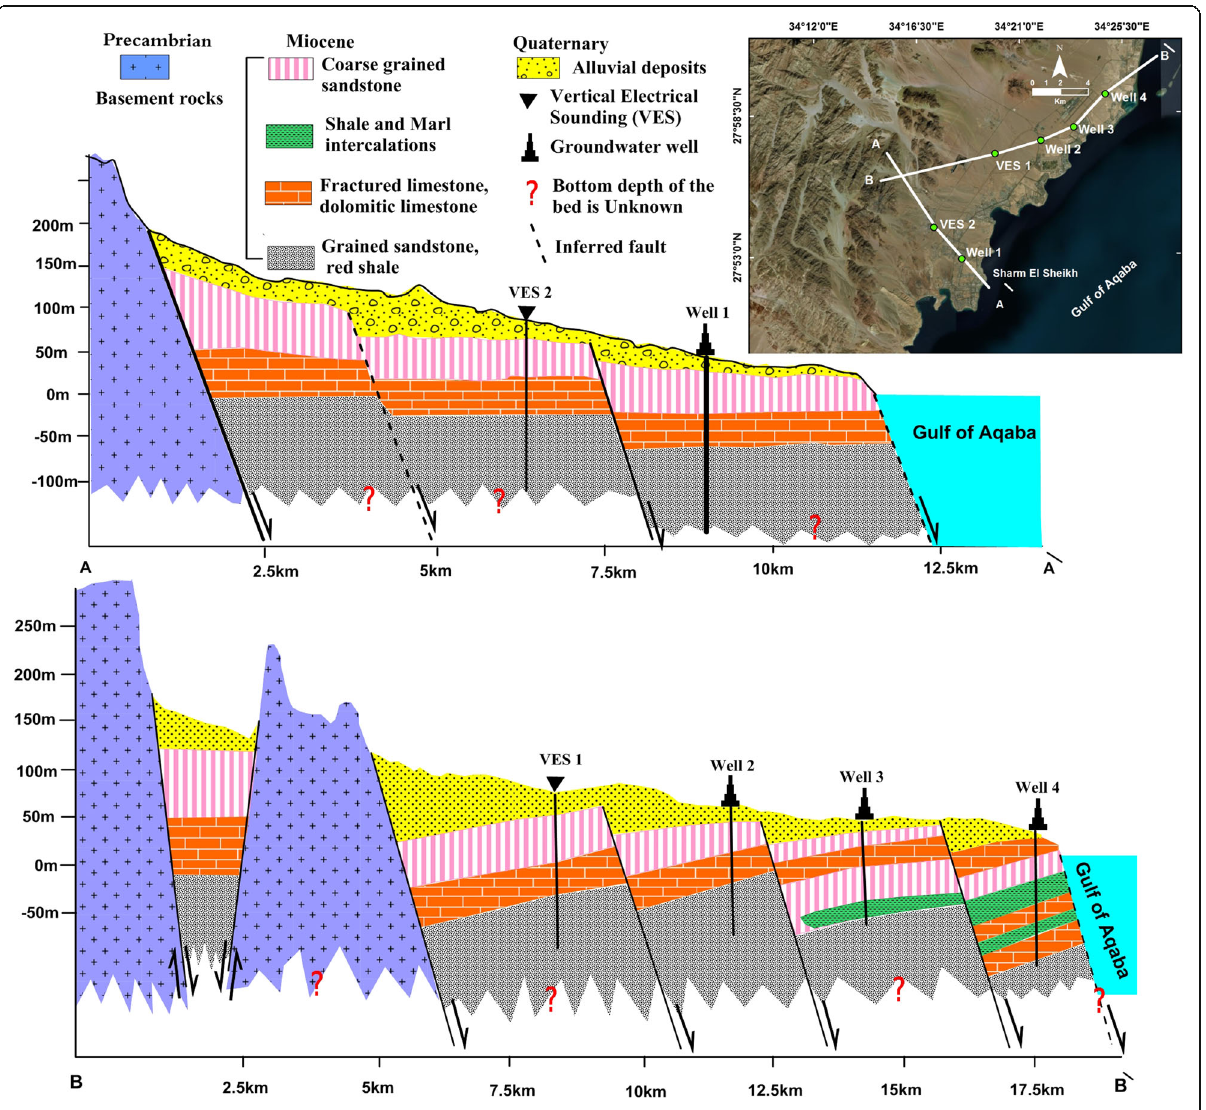
Fig. 12 Schematic cross sections. (A-A ’ ) indicates that the thickness of Miocene aquifer exceeds +200 m, where four inferred faults are recognized in the area between the basement terrains and the Gulf of Aqaba. (B-B ’ ) reveals that the area is dissected by a set of faults along the NE-SW direction. The Quaternary sediments have thickness up to 75 m between VES 2 and basement. The well logs and VES data are obtained from (Abdallah and El Hefnawy 2002 and Isawi et al.